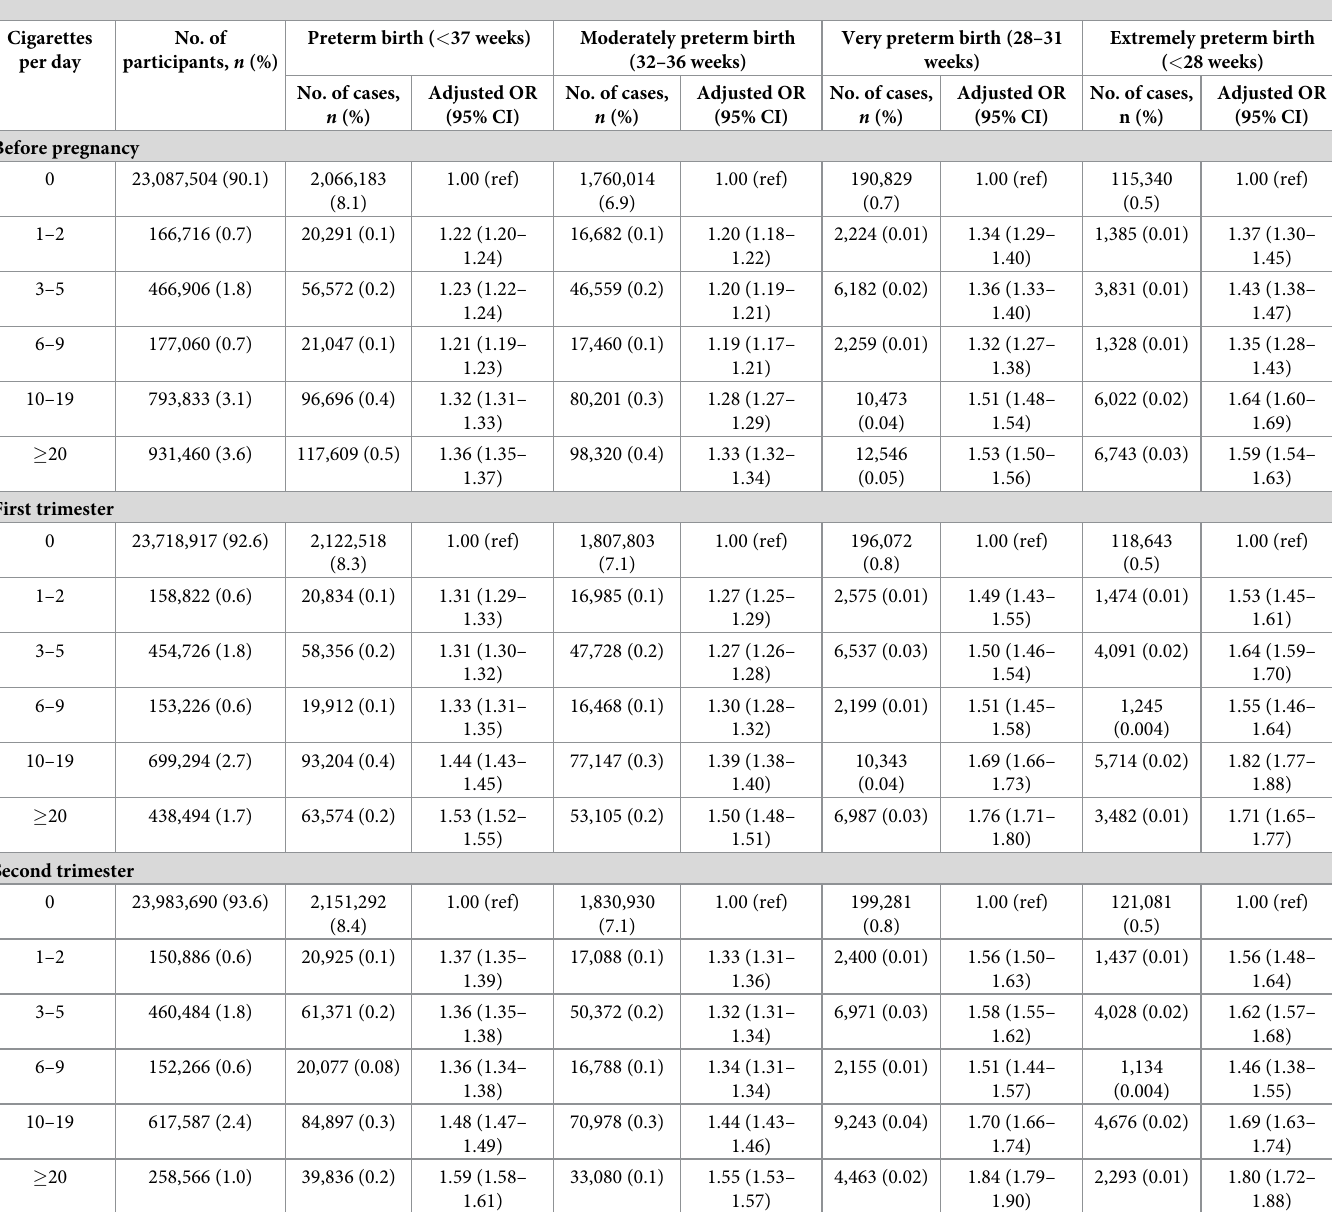
Table 2. Associations of the intensity of maternal cigarette smoking before and during pregnancy with risk of preterm birth. Cigarettes No. of per day participants, n